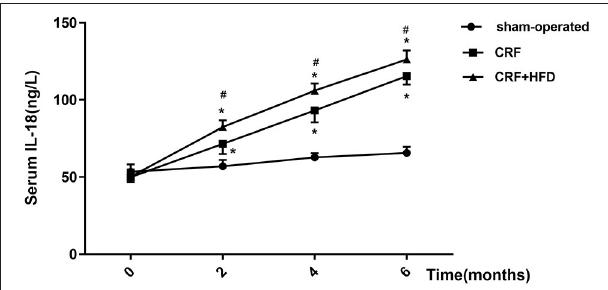
FIGURE 6 | Trend of serum IL-18 in rats of each group after operation. Six rats were included in each group. * P < 0.05 vs. sham-operated group; # P < 0.05 vs. CRF group. CRF, chronic renal failure; HFD, high fat diet.